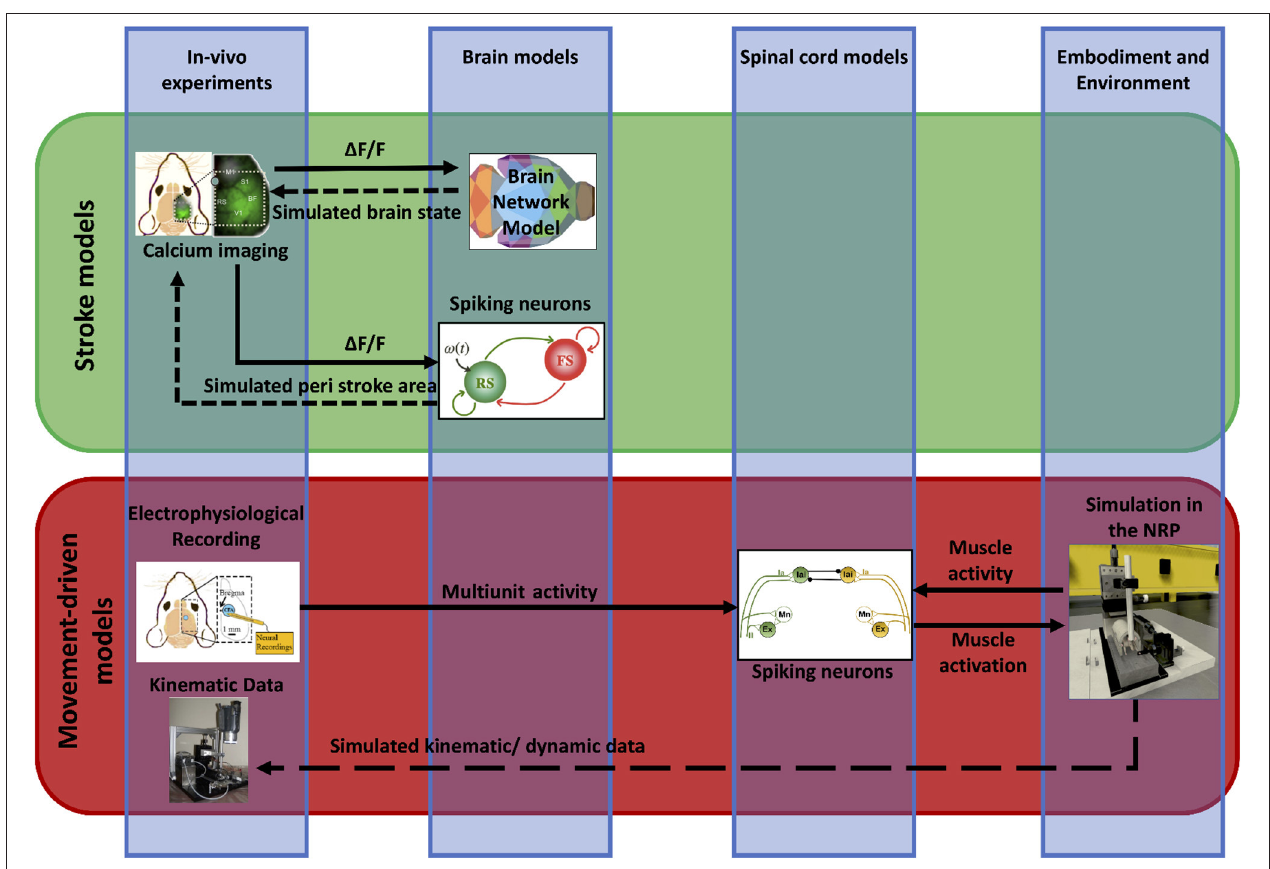
FIGURE 2 | Scheme of data and simulations. The scheme depicts the approach to build the Embodied brain framework from data to models and back. The workflow from data to models and simulation in the Embodied brain closed loops is shown. The upper, green box shows the Stroke models closed loop, the lower, red box shows the Movement-driven models closed loop. Colored images represent experiment data, brain and spinal cord models, and simulation of the environment (from left to right). Connections between the modeling components are presented as arrows: solid lines represent the output provided to other blocks; dashed lines indicate the output data of the models that are used for comparison with real data for